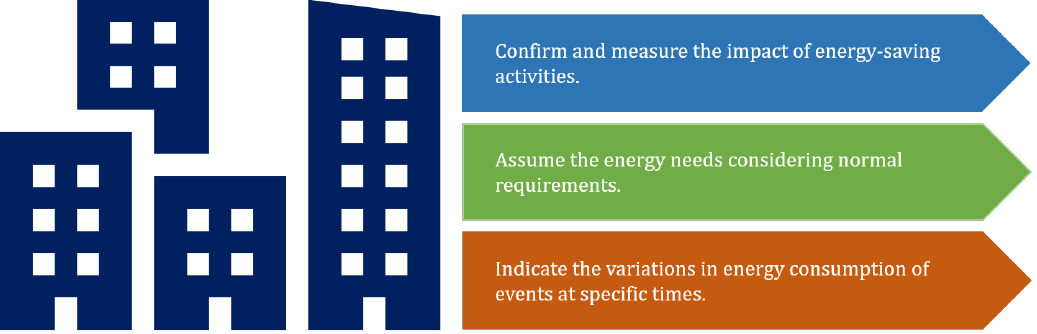
Figure 1. Building energy consumption forecasting objectives.